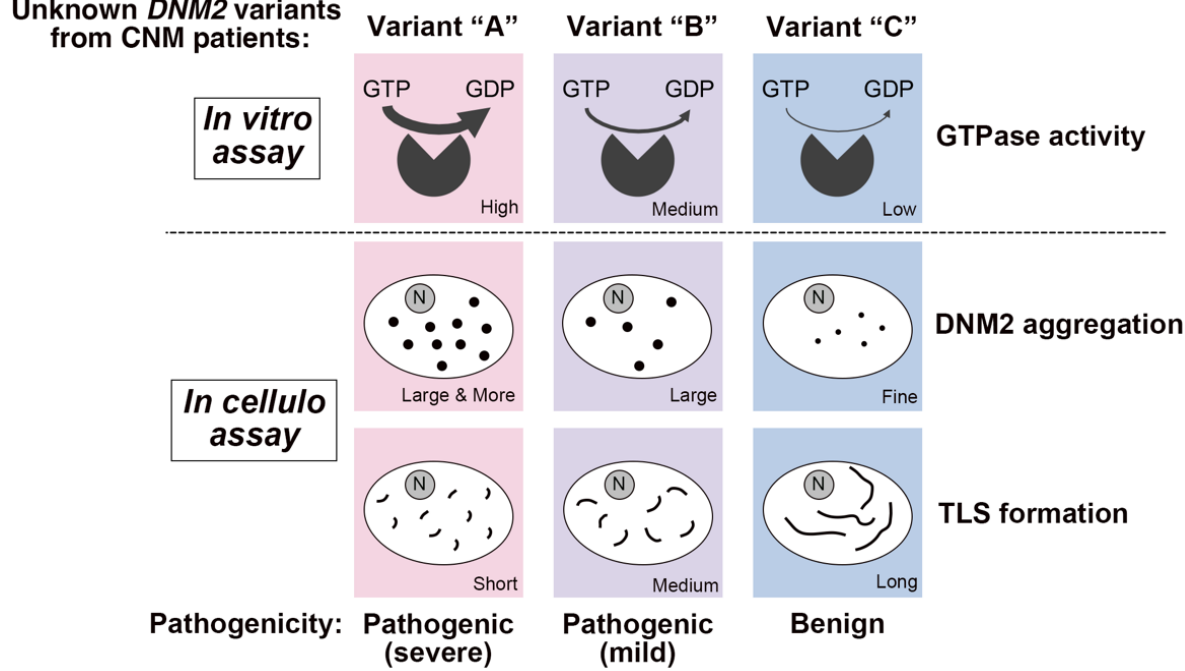
Figure 4. Determining pathogenicity of novel CNM variants by various analyses. Possible phenotypic summary of unknown variants identified from CNM patients analysed by various assays either in vitro (GTPase activity) or in cellulo (DNM2 aggregation and TLS formation) to determine their pathogenicity. N: nuclei.